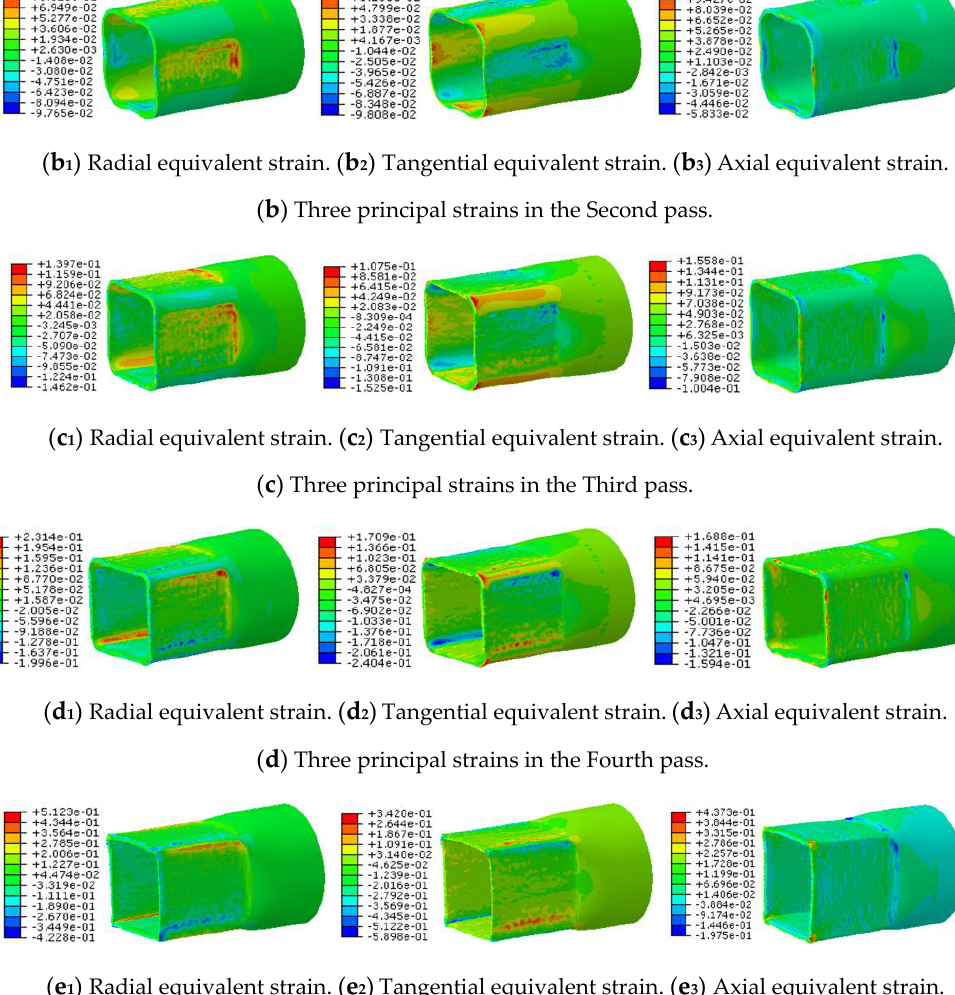
Figure 8. Three principal strains in the workpiece for each pass of the non-circular spinning process.